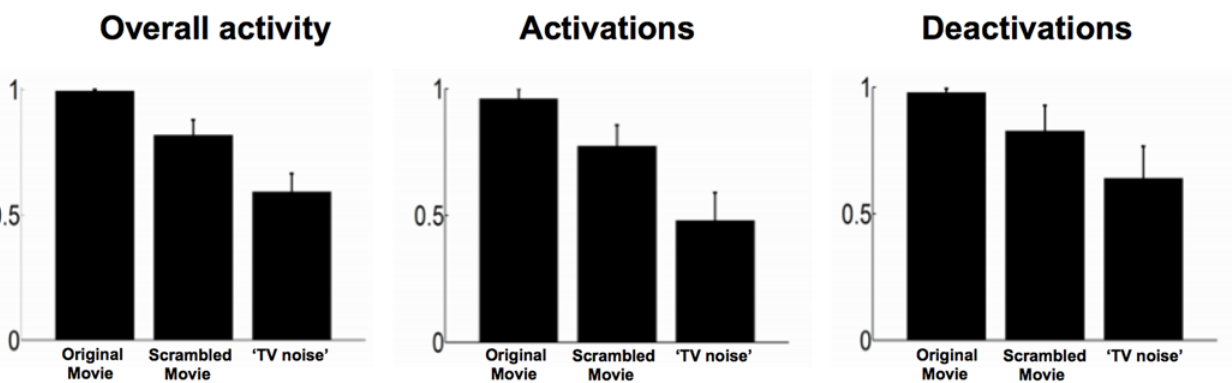
Fig 4. Lempel-Ziv complexity group values — comparison to a black screen baseline. Left panel: overall activations/deactivations (F test) group values. Middle panel: Lempel-Ziv complexity values for activations only (positive T test) Right panel: Lempel-Ziv complexity values for deactivations only (negative T test). For display purposes, each subject ’ s Lempel-Ziv complexity was normalized by its individual maximum value across all conditions. Bar graphs show group mean and standard error of the mean in each condition.